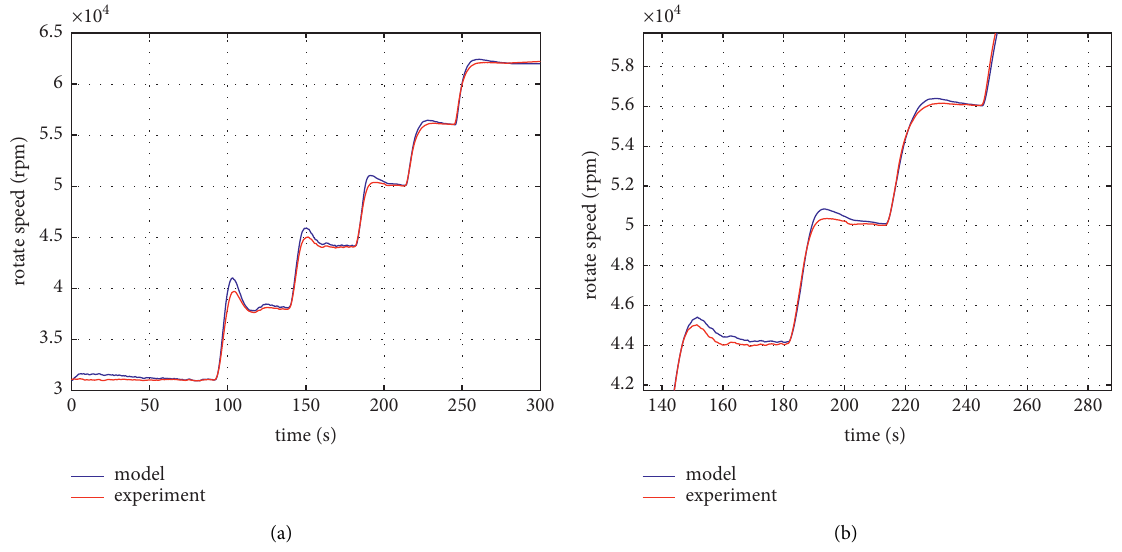
Figure 14: Rotate speed simulation results. (a) Rotate speed results in starting process. (b) Rotate speed results during 140s to 280s.